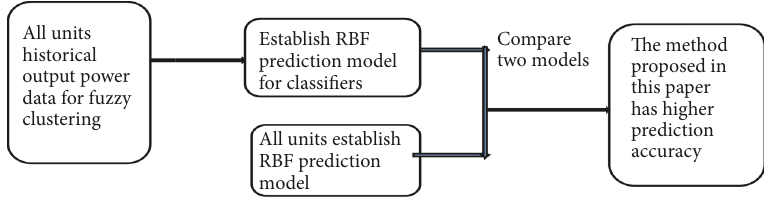
Figure 1: Fuzzy clustering and RBF network prediction model flow